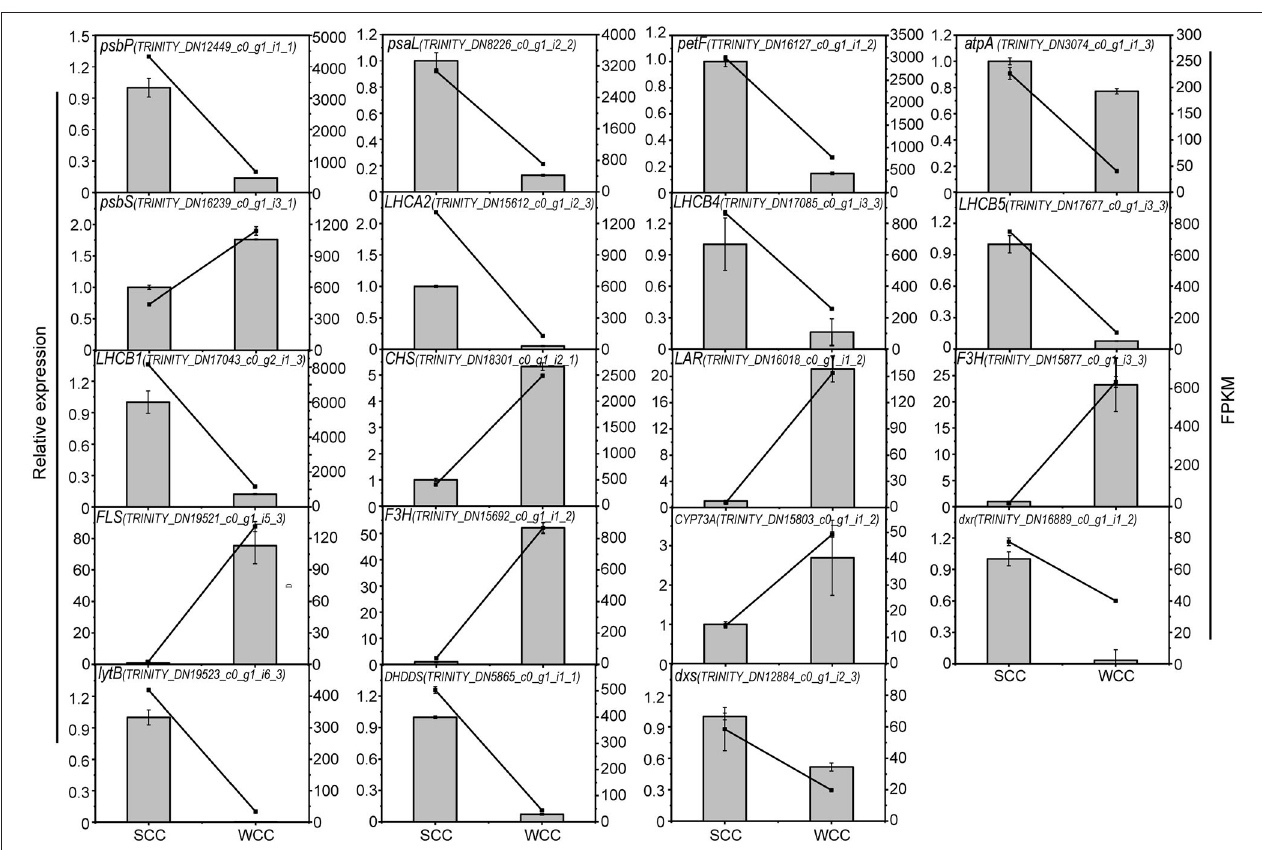
FIGURE 9 | Quantitative real-time polymerase chain reaction (qRT-PCR) validation of select genes involved in the photosynthesis, flavonoid biosynthesis, and terpenoid biosynthesis pathways in C. fortunei needles. SCC and WCC represent summer and winter Chinese cedar needle samples, respectively. The line and bar chart represent FPKM and relative expression level, respectively, and each value is the mean ± standard deviation (SD), n = 3. FPKM, fragments per kilobase per million. The abbreviation of each gene is as follows: CHS , chalcone synthase ; CYP73A , cytochrome P450 ( CYP ); DHDDS , dehydrodolichyl diphosphate synthase ; DXR , 1-deoxy-d-xylulose 5-phosphate reductoisomerase ; DXS , 1-deoxy-D-xylulose-5-phosphate synthase ; F3H , flavanone 3-hydroxylase ; FLS , flavonol synthase gene ; F-type ATPase ( atpA ) and light-harvesting chl protein complexes ( Lhca2, and Lhcb1, 4, 5 ); photosynthetic electron transport (petF ); photosystem I ( psaL ); photosystem II ( psbP , S ); ispH , 4-hydroxy-3-methylbut-2-en-1-yl diphosphate reductase ; and LAR , leucoanthocyanidin reductase